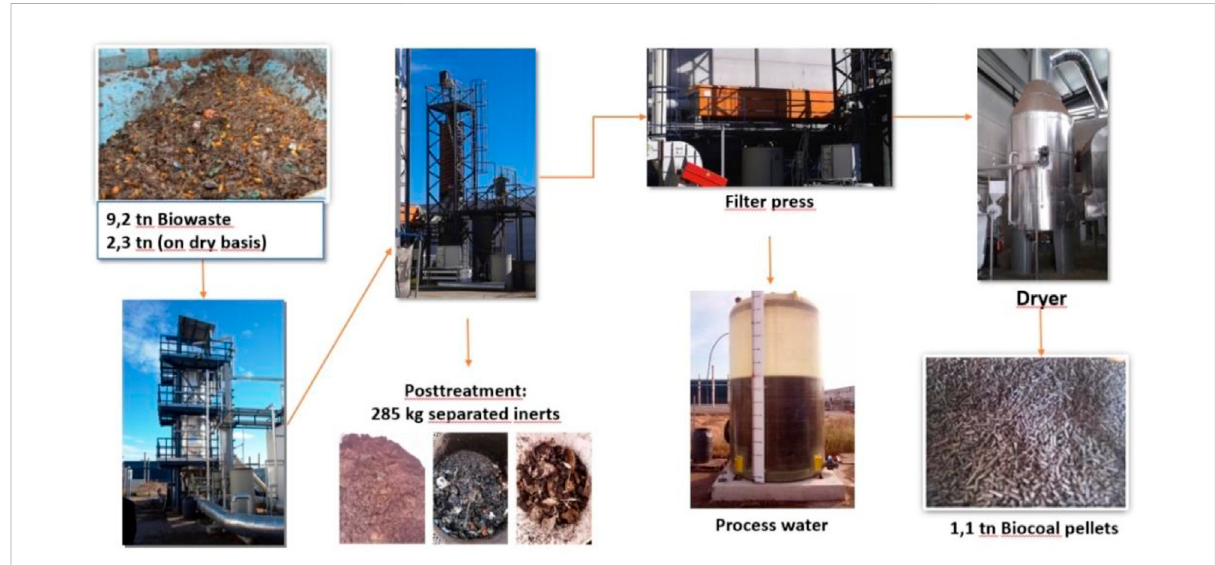
FIGURE 7 Diagram of the hydrothermal carbonization of the post-fermentation sludge.